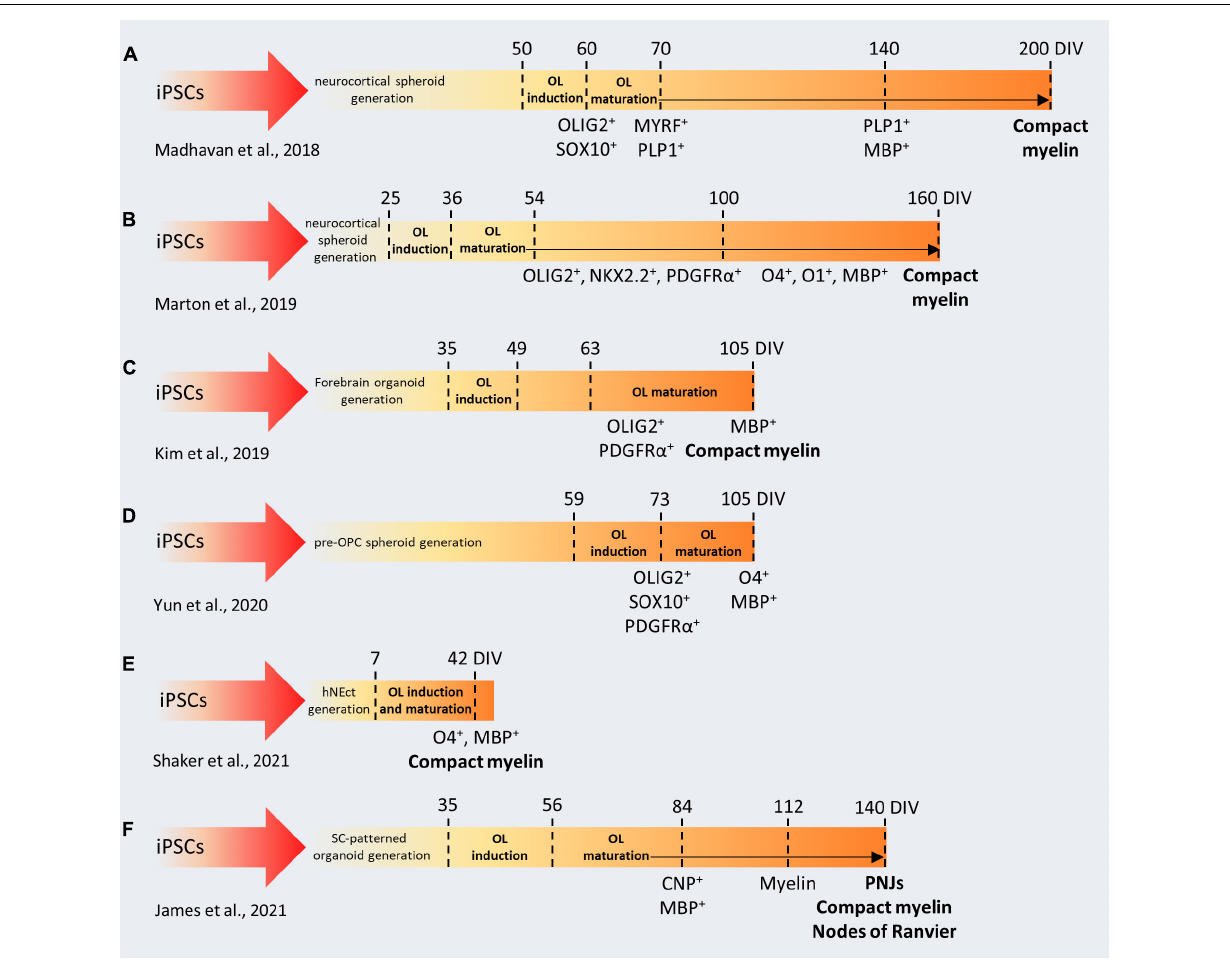
FIGURE 3 | Comparison between protocols used to generate brain organoids containing myelinating oligodendrocytes. (A–F) In the first phase of each protocol, iPSCs are cultured and patterned to generate 3D brain-like structures (forebrain, spinal cord, neuroectoderm). Then, OL induction and maturation is achieved by using specific soluble factors (e.g., PDFG-AA, IGF1, FGF2, T3). iPSCs, induced pluripotent stem cells; DIV, days in vitro ; OL, oligodendrocyte; OPC, oligodendrocyte precursor cell; SC, spinal cord; hNEct, human neuroectodermal layer; PNJs, paranodal axoglial